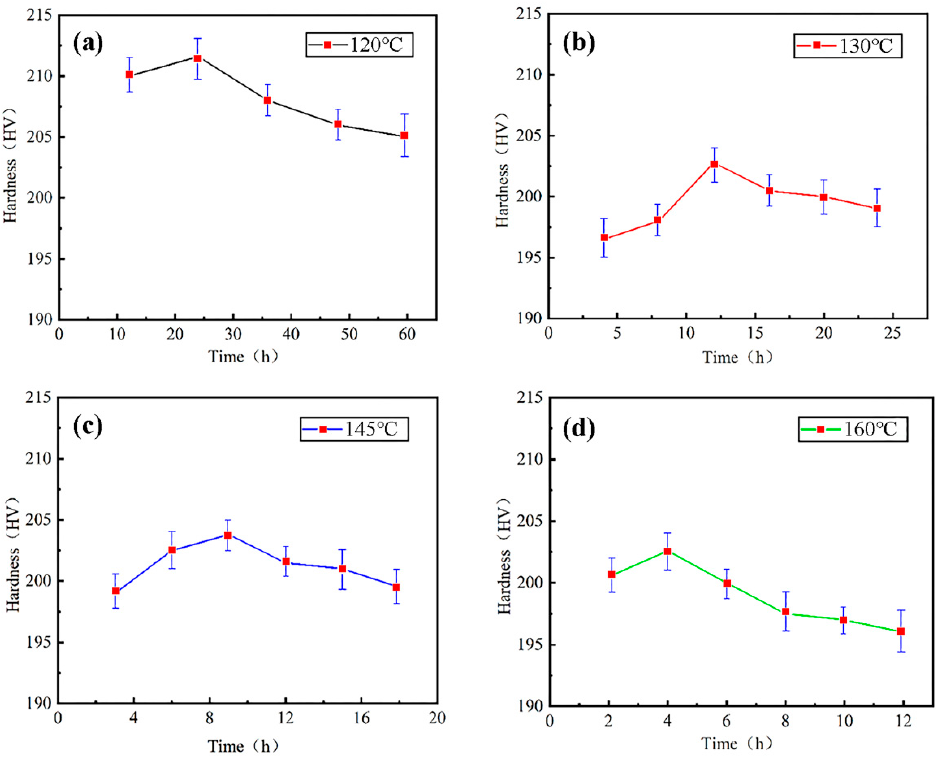
Figure 8. Aging hardness curve under different temperatures ( a ) 120 ◦ C, ( b ) 130 ◦ C, ( c ) 145 ◦ C, and ( d ) 160 ◦ C. Table 3. Mechanical property parameters of Al-Zn-Mg-Cu solid solution alloy at different heat treatment